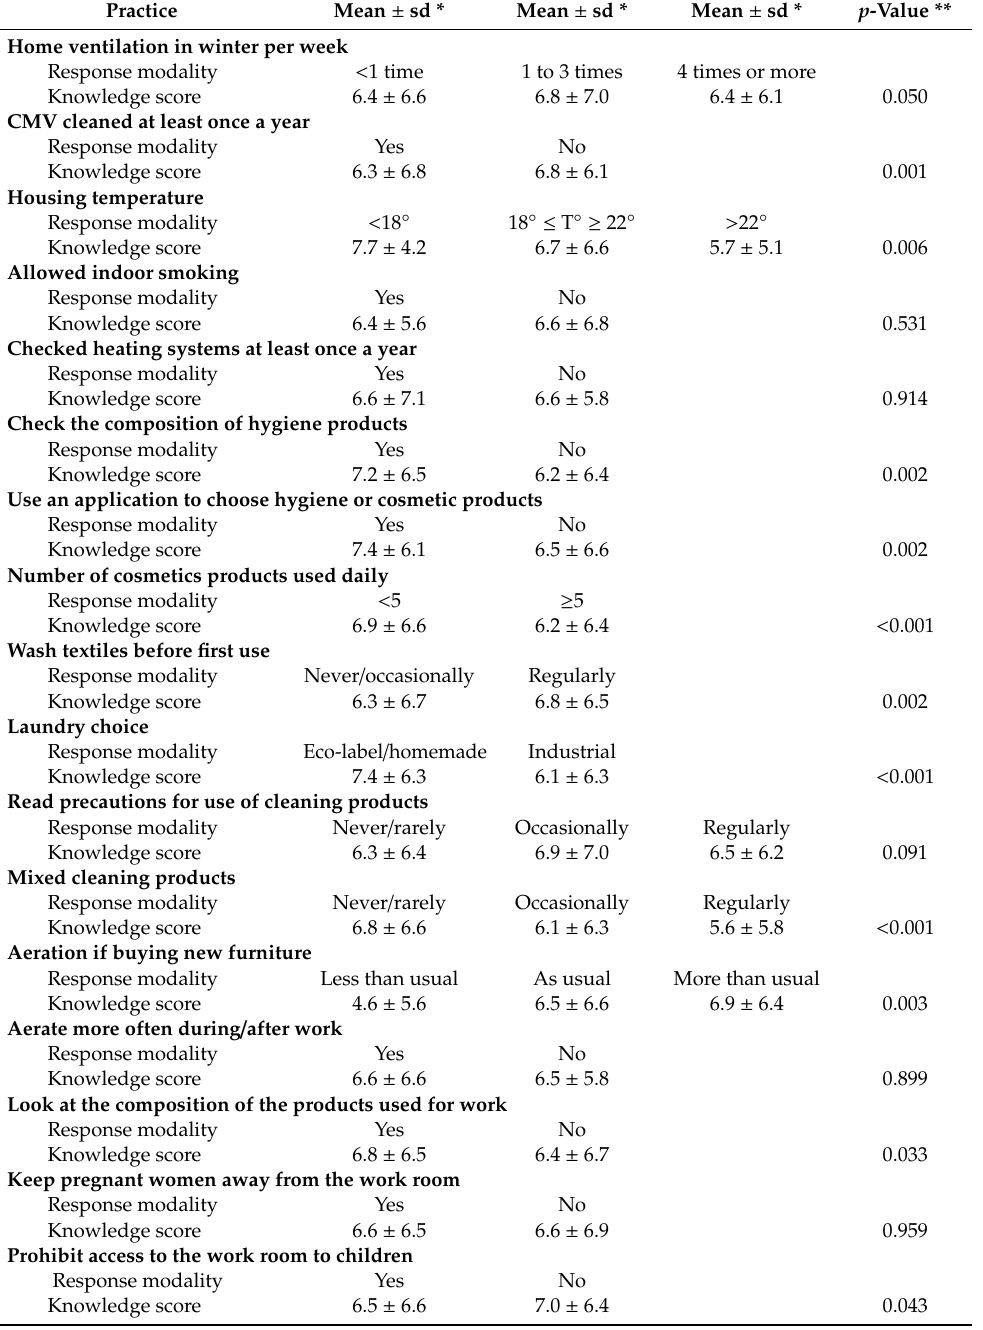
Table 7. Practices according to knowledge